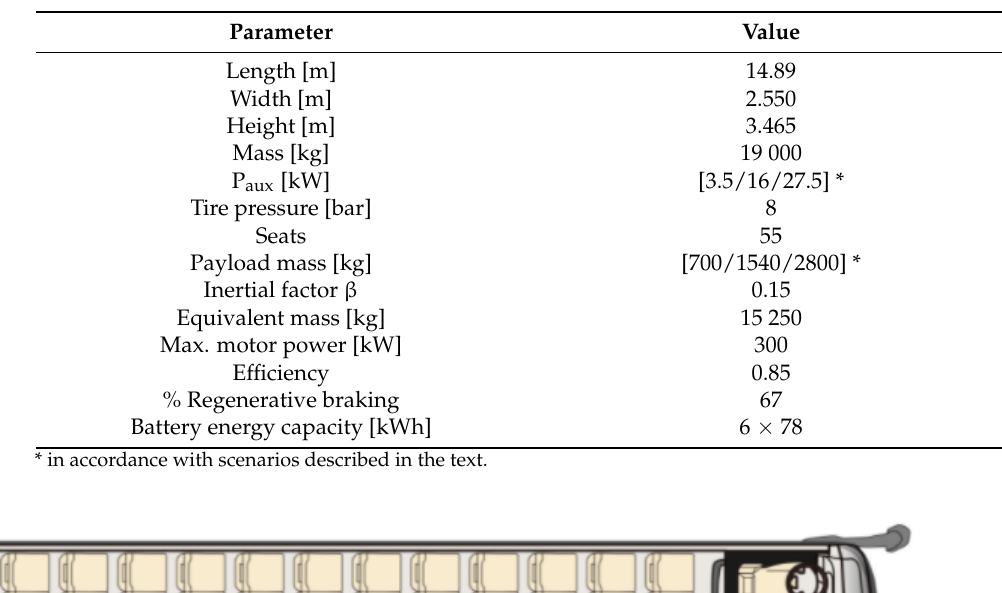
Table 2. Electric bus technical details.